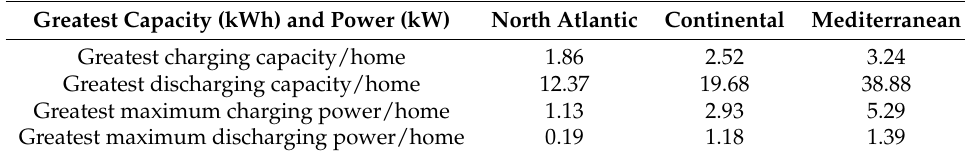
Table 5. Greatest capacity and power ratios per climate area in 2019.